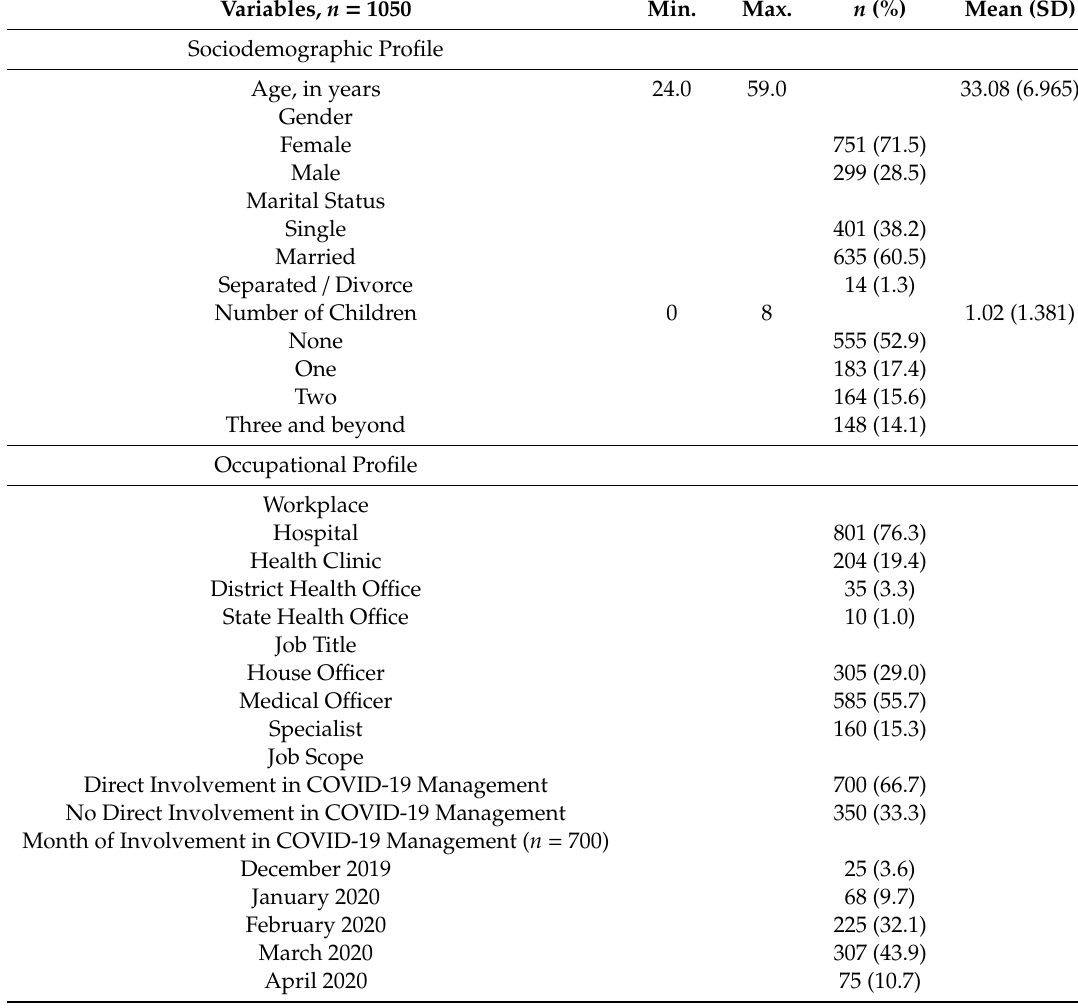
Table 2. Participants’